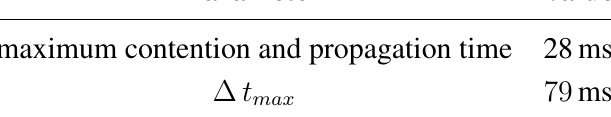
Table 5. Simulation settings.